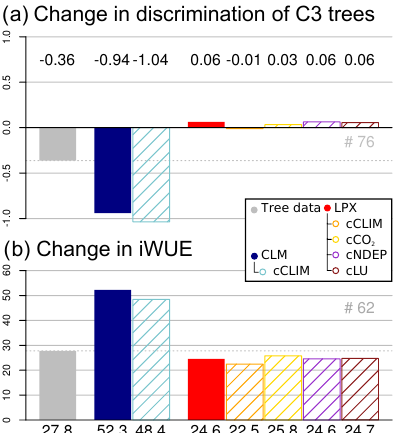
Figure 10. Century-scale changes in (a) discrimination (cid:49) i and (b) iWUE (%) of C3 trees as calculated from tree-ring δ 13 C data (gray) and from results of the standard simulations of CLM4.5 (filled blue) and LPX (filled red) as well as from factorial runs (pat- tern). Individual driving factors (climate, CO 2 , N-deposition, and land use) were kept constant in the factorial runs, as explained in the main text and indicated by the legend. The number of avail- able records is indicated in each subpanel. All estimates are base on decadal means: (a) 1980s minus 1900s; (b) 1990s minus